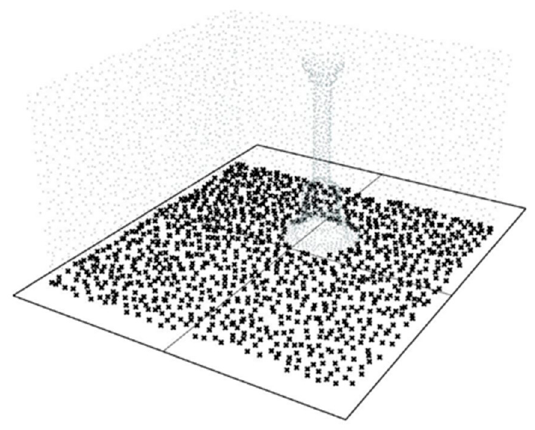
Figure 5. Subset with a clipping plane.